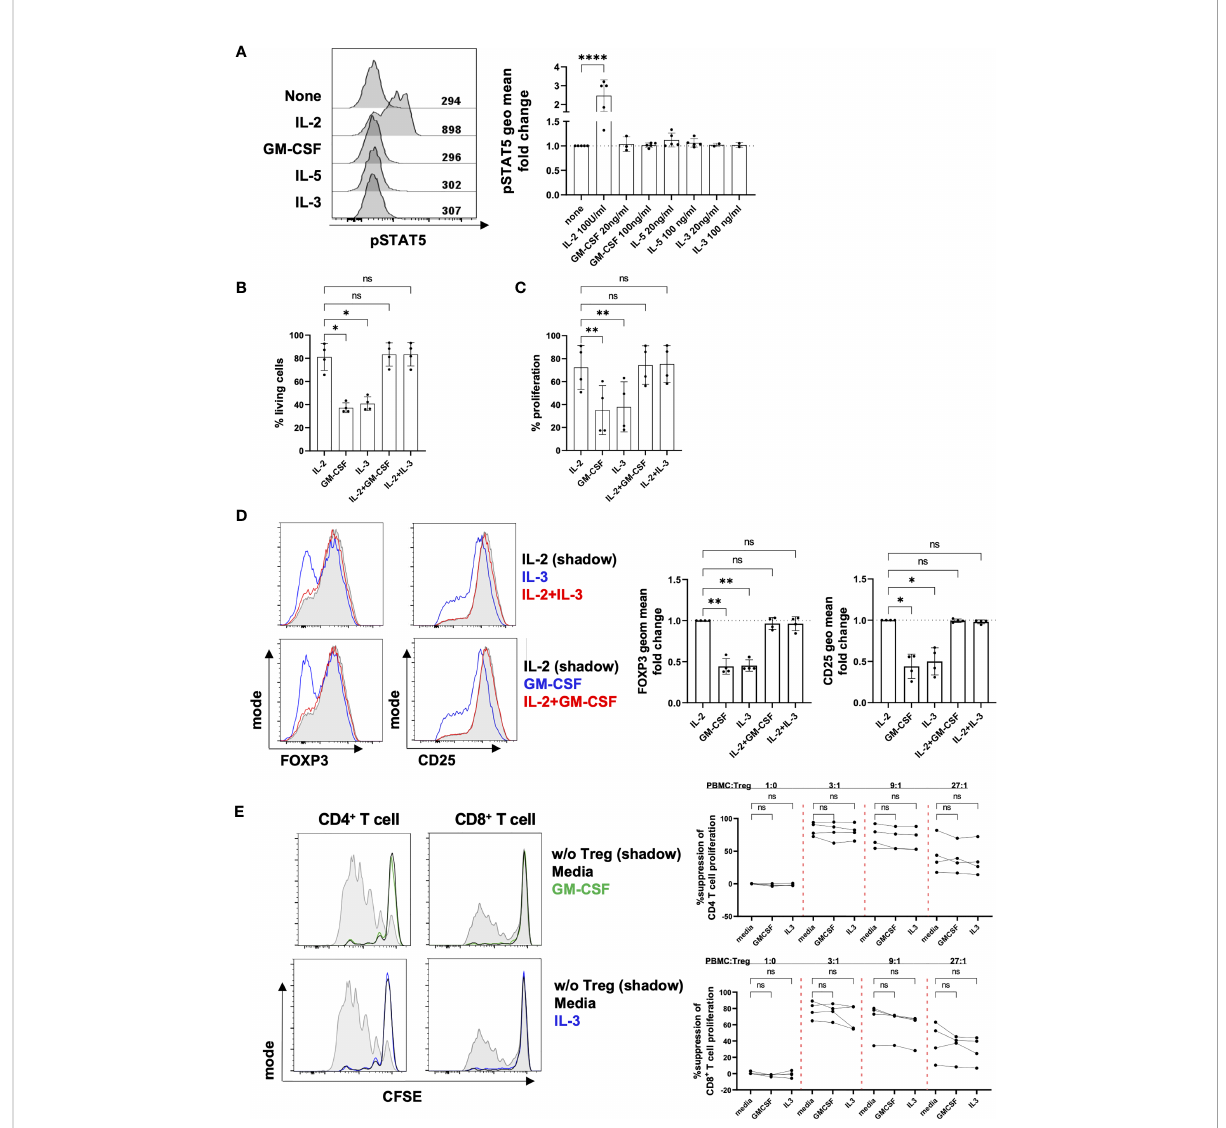
FIGURE 3 Effect of b common chain cytokines on Tregs. (A) After 4 days of in vitro stimulation with 1µg/ml anti-CD3 mAb, 1µg/ml anti-CD28 mAb and 25 U/ml IL-2, Tregs were rested for 2 hours in the absence of TCR stimulation and IL-2 prior a 2-hour culture with different cytokines as indicated in the fi gure. STAT5 phosphorylation was measured by fl ow cytometry. Fluorescence intensity of pSTAT5 was calculated as geometrical mean (geo mean) and normalized to pSTAT5 in cells cultured in the absence of any cytokine. Left panel: fl uorescence intensity of pSTAT5 is shown for 1 representative donor. Right panel: combined data from 2-5 independent donors. (B-D) Four day-stimulated Tregs were labelled with CTV proliferation dye and re-stimulated for four further days using anti-CD2/CD3/CD28 mAb-coated beads in the presence of different cytokines as indicated (IL-2: 25U/ml, GM-CSF and IL-3: 100ng/ml). (B) Cell viability, (C) proliferation (D) phenotype and (E) in vitro suppressive capacity were analyzed by fl ow cytometry. Treg suppressive activity was assessed by inhibition of proliferation of CFSE-labelled PBMCs when co-cultured with stimulated autologous Tregs in the presence of anti-CD2/CD3/CD28 mAb-coated beads. Cell proliferation was assessed by dilution of CFSE dye in CD4 + or CD8 + T cells. Tregs were excluded of responder CD4 + T cells by gating out CFSE negative cells. Left panel: histograms show data from one representative donor. Grey shadow: T cell proliferation in the absence of Tregs; black line: T cell proliferation when co-cultured with Tregs; green/blue line: T cell proliferation when co-cultured with Tregs in the presence of GM-CSF or IL-3. Right panel: data show mean ± SD of percentage of suppression of cell proliferation for 4 independent donors. Signi fi cance was calculated by one-way ANOVA with Holm-Sidak ’ s multiple comparisons test. ns for P > 0.05, * for P ≤ 0.05, ** for P ≤ 0.01, **** for P ≤